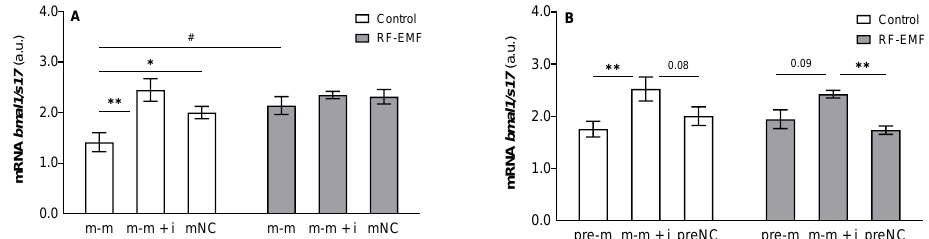
Figure 6. Effect of miR-34a administration on bmal1 mRNA expression in DLD1 cells under control and RF-EMF conditions. Cells were transfected with ( A ) miR-34a-5p (m-m), ( B ) pre-miR-34a (pre-m), mimic of mature miR-34a together with the miR-34a inhibitor (m-m + i) or corresponding negative control of mature and pre-miRNA (mNC and preNC, respectively). The data were relativised to the corresponding negative control measured under control conditions and presented as the mean ± SEM (n = 4). a.u. — arbitrary units. Two-way ANOVA, Tukey ’ s post hoc test, * p < 0.05, ** p < 0.01, comparison between groups transfected with different oligos within the control or RF-EMF treatment. Two- way ANOVA, Šídák’ s multiple comparisons test, # p < 0.05 comparison between control and RF-EMF groups.